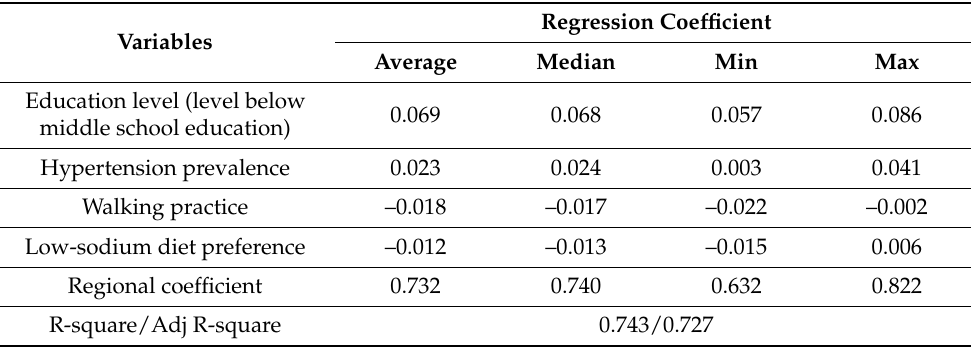
Table 3. Risk factors affecting dementia prevalence